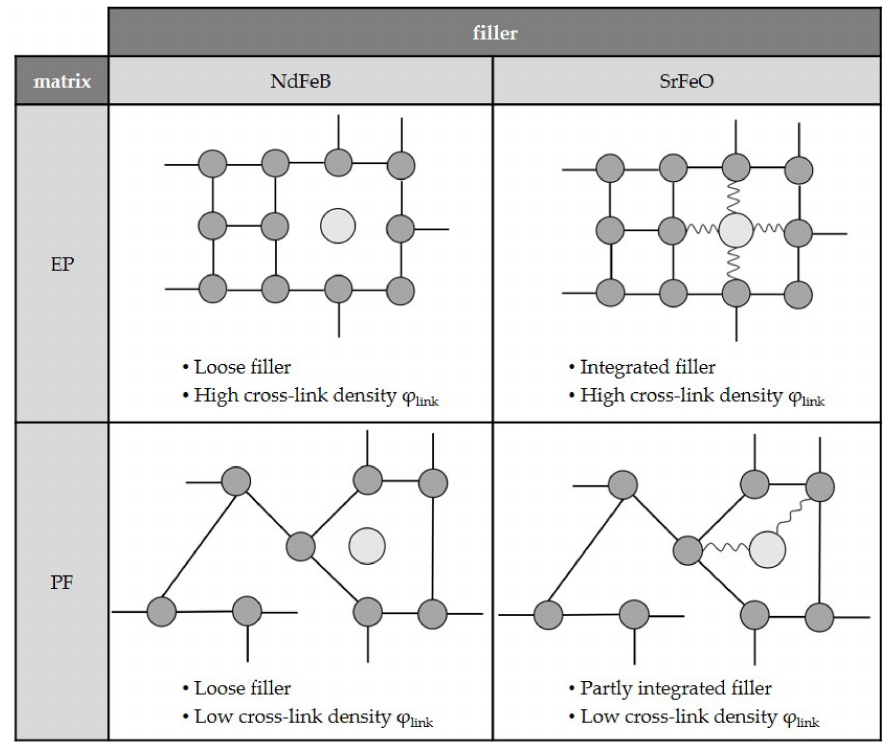
Figure 8. Network and cross-link structures in terms of the matrix material and the filler (SrFeO: strontium-ferrite-oxide; NdFeB: neodymium-iron-boron; PF: phenolic resin; EP: epoxy